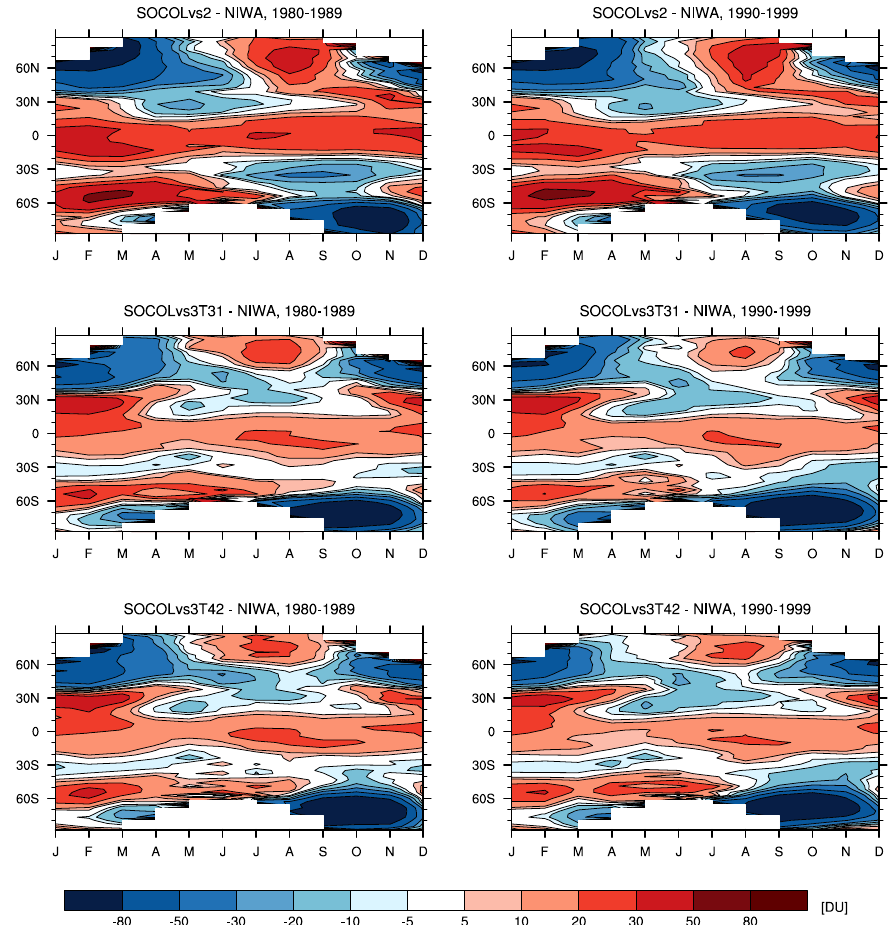
Fig. 12. Differences of zonal-mean total ozone between the different SOCOL simulations and NIWA observations averaged over the two 10yr periods, 1980–1989 (left) and 1990–1999